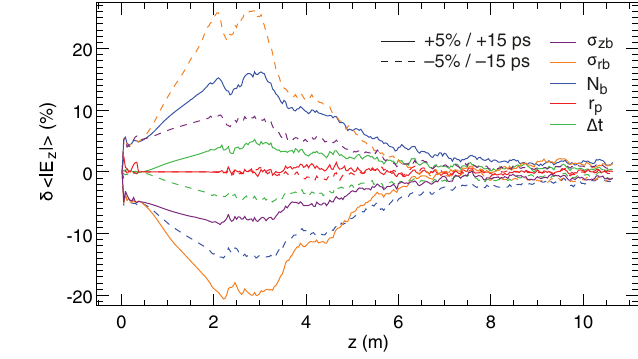
as a FIG. 2. Relative deviation of the average absolute value of E z pe resulting from the parameter scans with respect to the baseline result (see Fig. 1), where δ hj E z ji ¼ ðhj E z ji − hj E z; hj E ji z; baseline